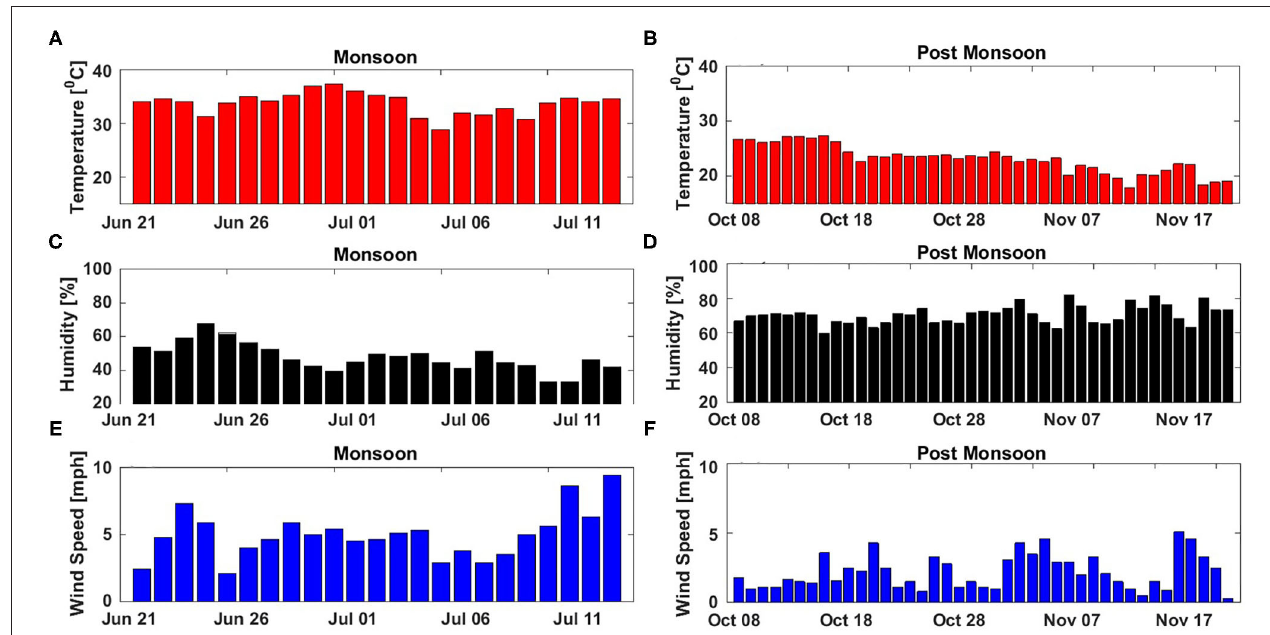
FIGURE 3 | Daily variation of meteorological parameters; (A,B) air temperature (in ◦ C), (C,D) humidity (in %), and (E,F ) wind speed (in mph) during the monsoon (21 June − 13 July 2019) and post-monsoon (11 Oct − 20 Nov 2019) seasons, respectively.